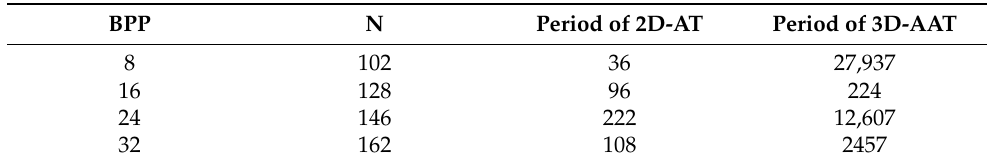
Table 10. Periods of 2D-AT and 3D-AT.